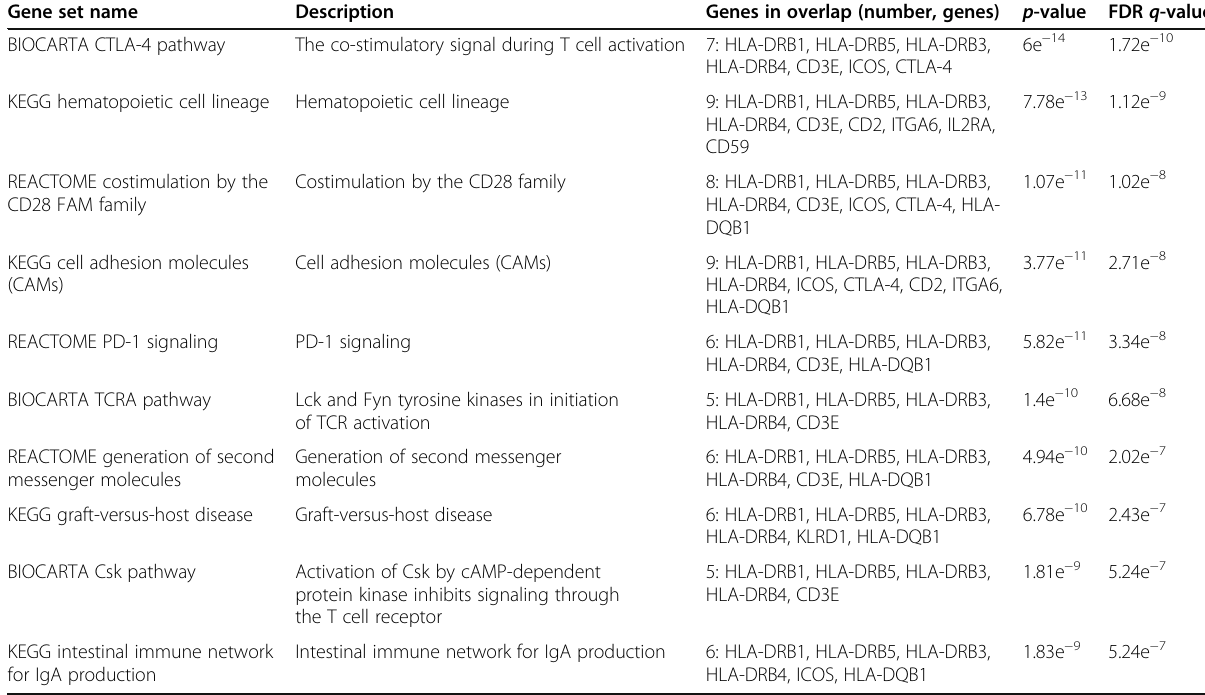
Table 3 Analysis of the overlap of the cured genes with canonical pathways annotated sets in